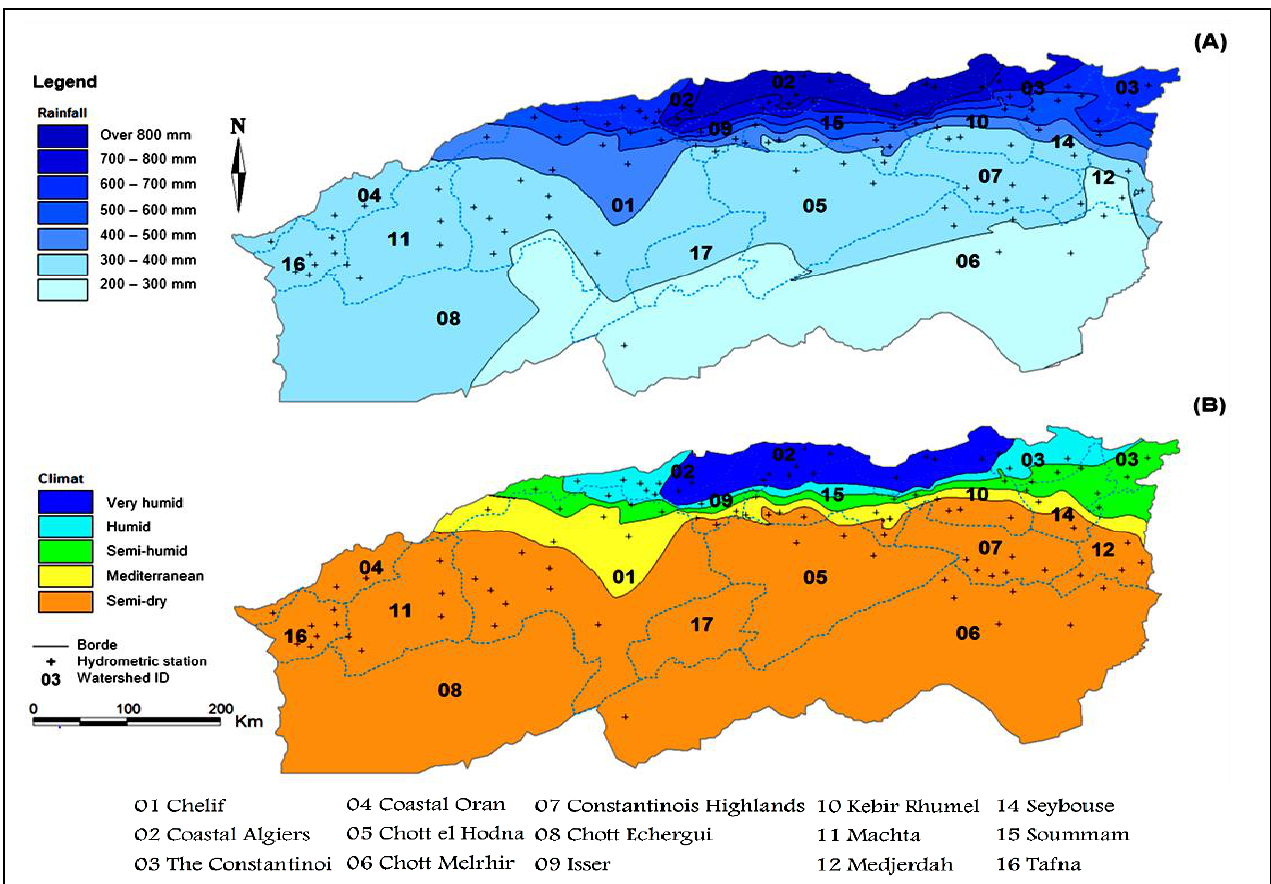
Figure 3. Map of spatial inter-annual rainfall distribution ( A ), followed by bioclimatic classification ( B ) of northern Algeria.